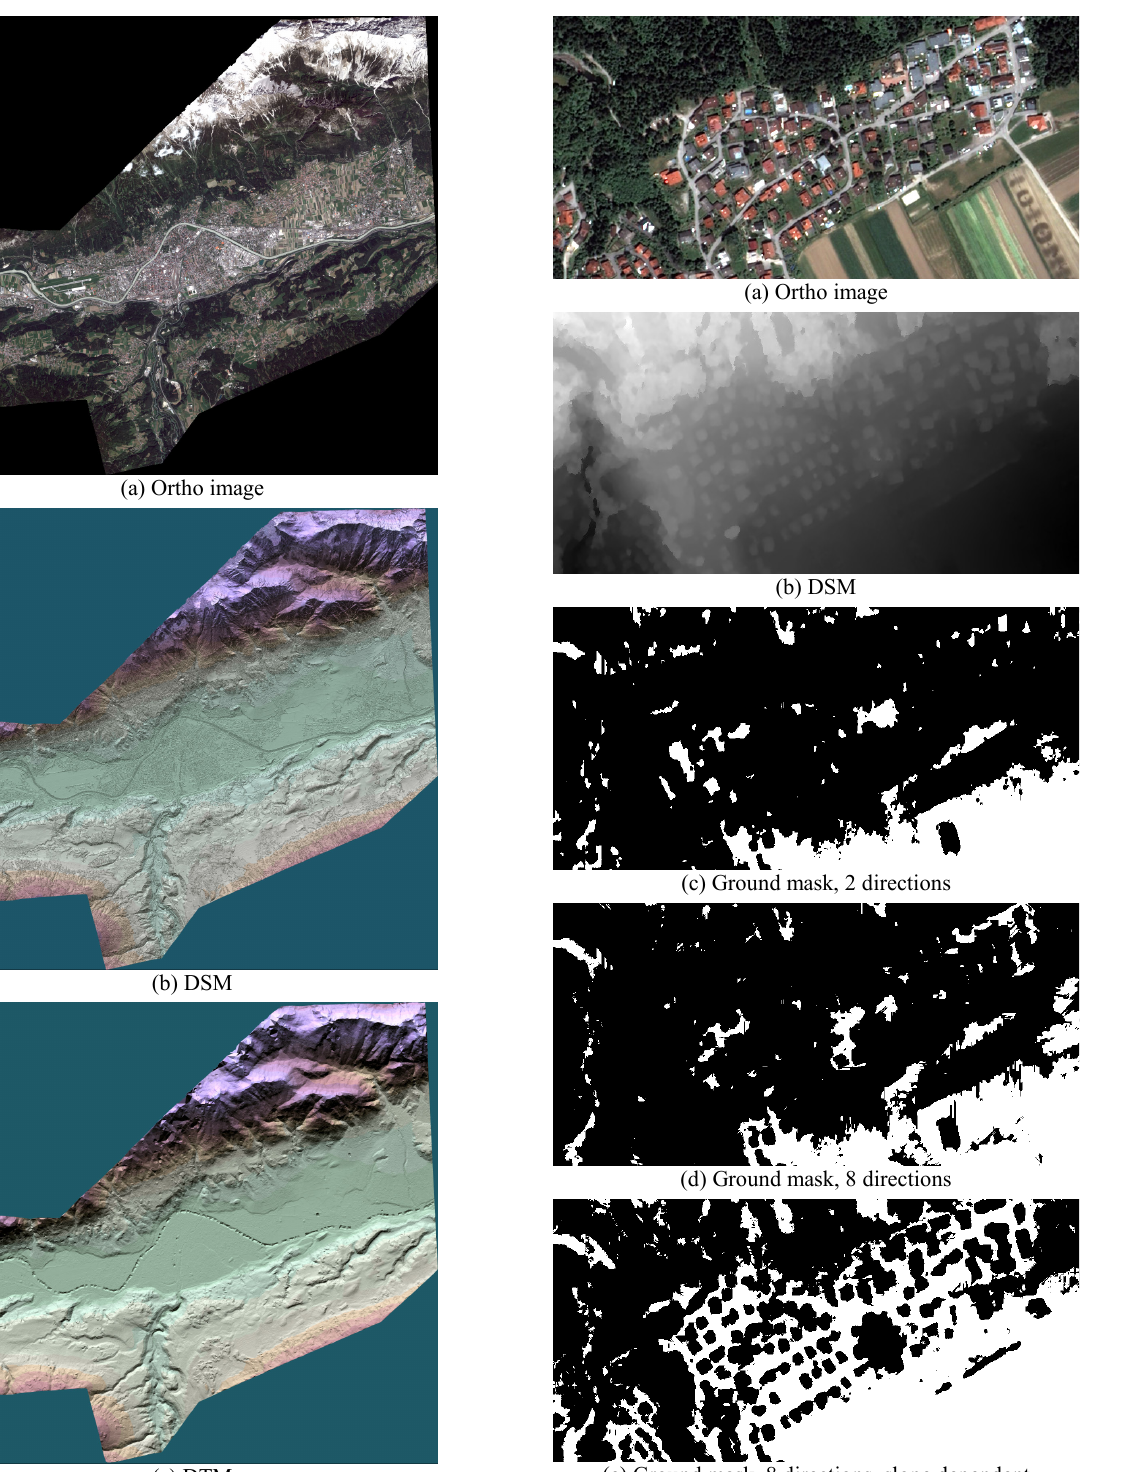
Figure 4. Pléiades pansharpened true-ortho image (a) and relief shaded presentations of DSM (b) and the derived DTM (c).